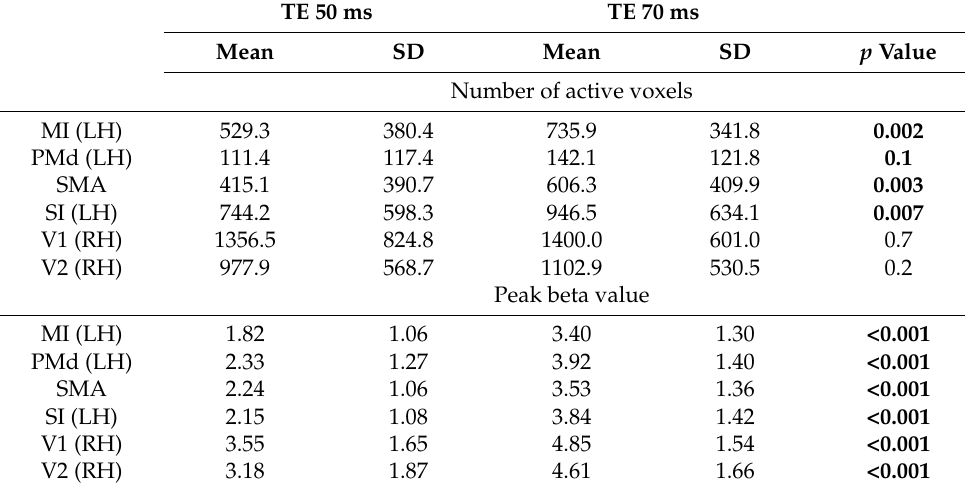
Table 3. Average extent of activation (number of active voxels) and strength of activation (peak beta values) in each TE condition.